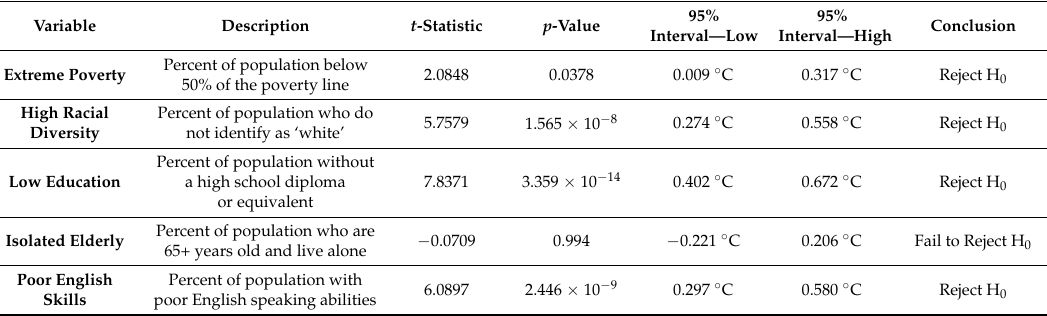
Table 2. Results of Student’s t -tests: Statistical significances. Tests which have a p -value greater than 0.05 are considered to have failed to reject H 0 .